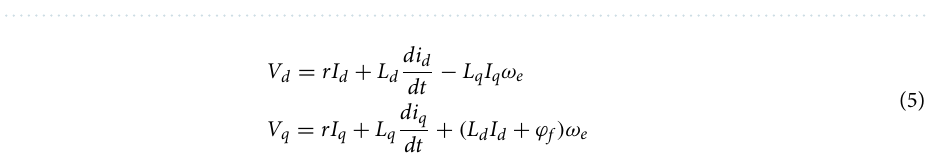
Figure 6. Stator and rotor of